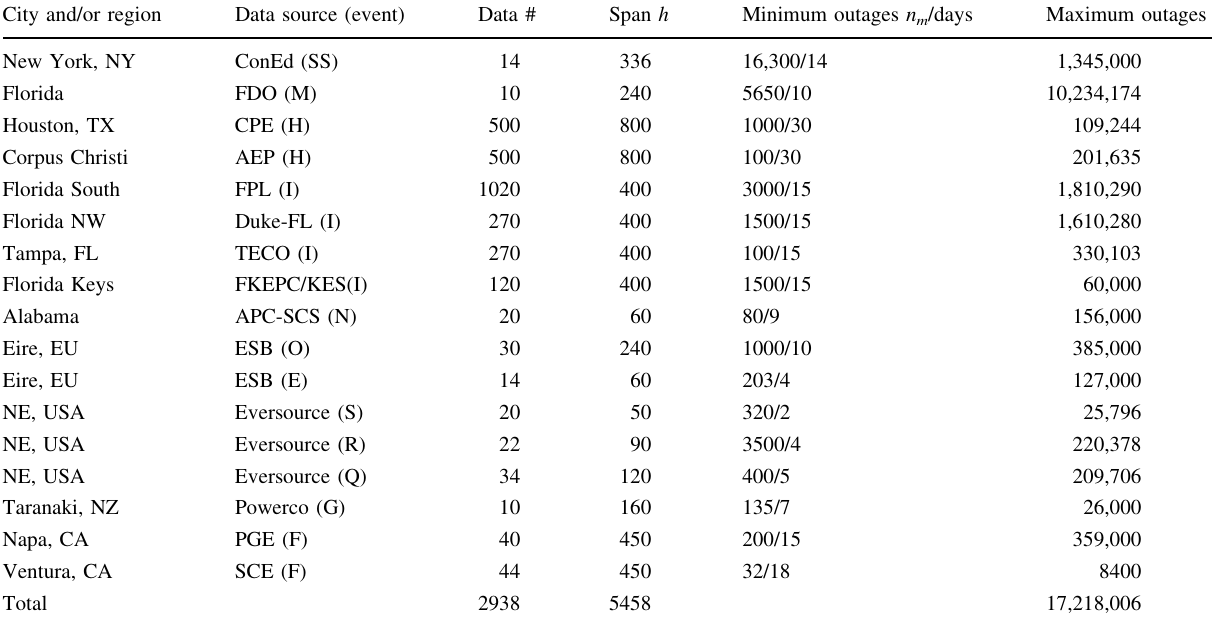
Table 1 Extreme event outage data summary City and/or